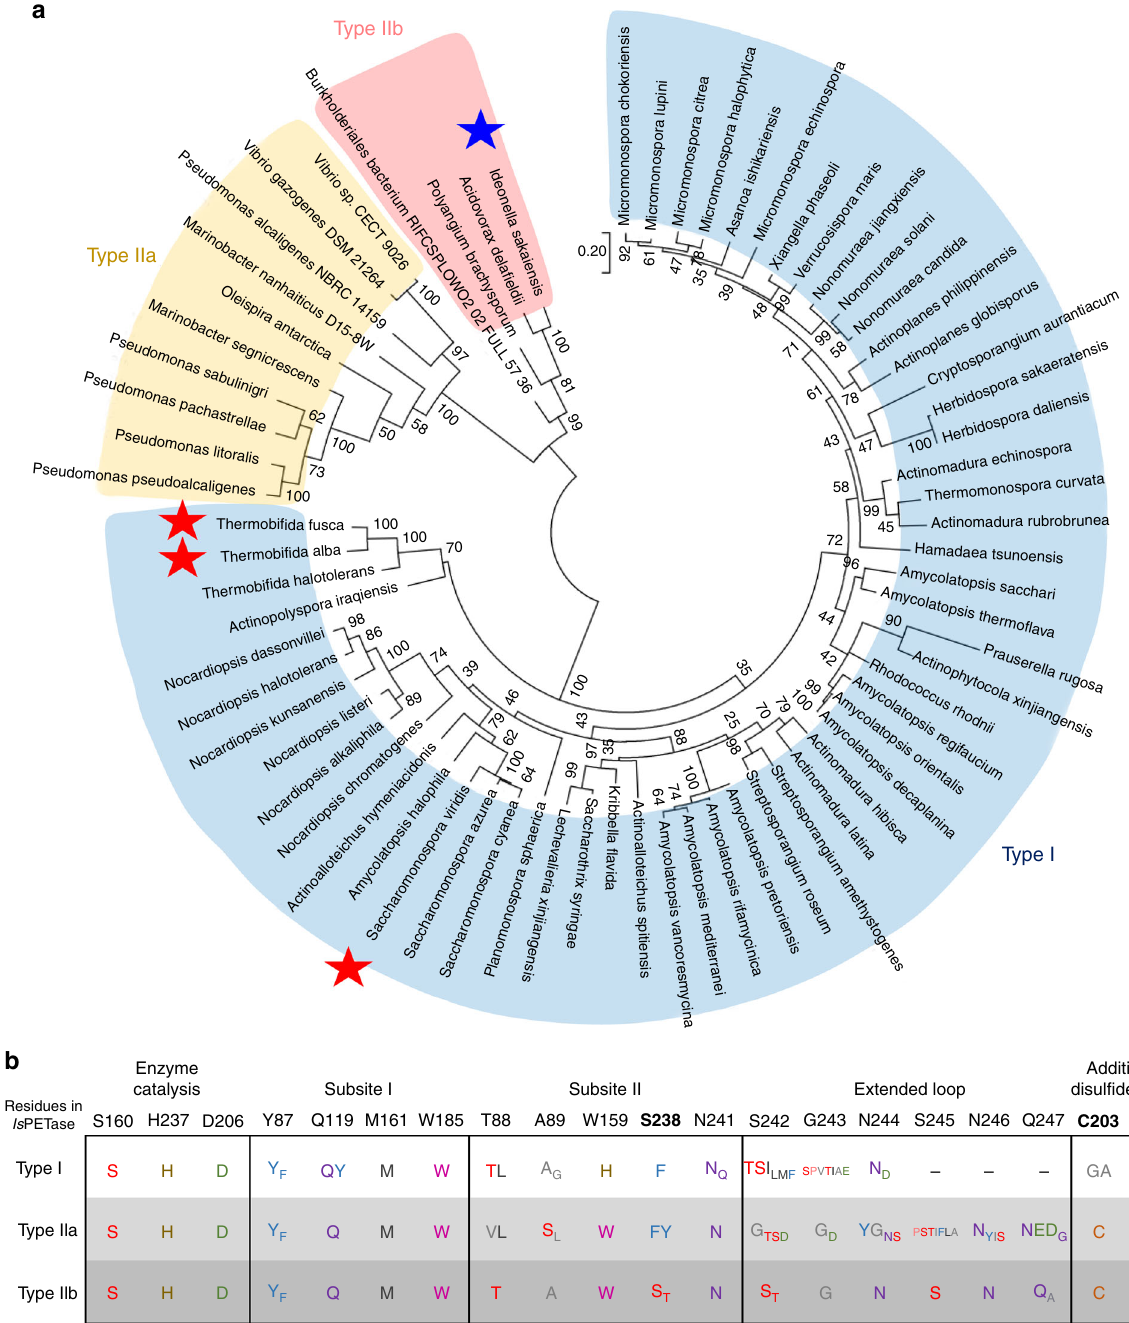
Fig. 6 Phylogenetic tree and comparative analysis of PET-degrading enzymes. a Unrooted maximum likelihood tree of the PET-degrading enzymes. The phylogenetic tree was drawn as a circle model. Bootstrap values are shown at each node as percentage of 100 replicates. Type I, type IIa, and type IIb of the PET-degrading enzymes are labeled as different color schemes. Is PETase is indicated by a blue-colored star, and other three PET-degrading enzymes whose structures are determined are indicated by a red-colored star. b Amino-acid sequence alignment of key residues in PET-degrading enzymes. The key residues involved in the enzyme catalysis, the constitution of subsite I and subsite II, the extended loop, and the additional disul fi de bond in Is PETase